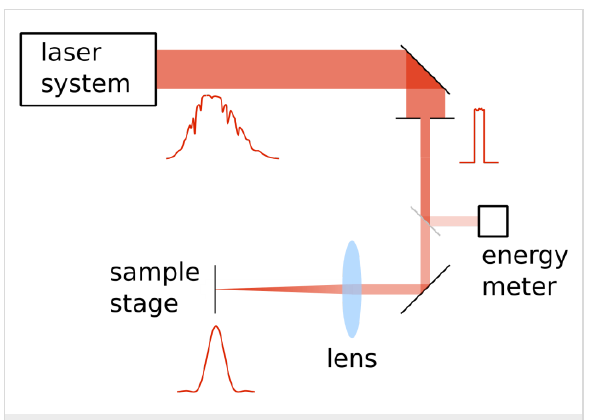
Figure 1: Optical set-up. The sample is mounted on an x–y micro- meter stage and can be moved reversibly below a video microscope, which allows to determine the position for irradiation on a micrometer scale. The beam diameter behind the aperture is 2 mm, the focal length of the lens is varied between 200 and 75